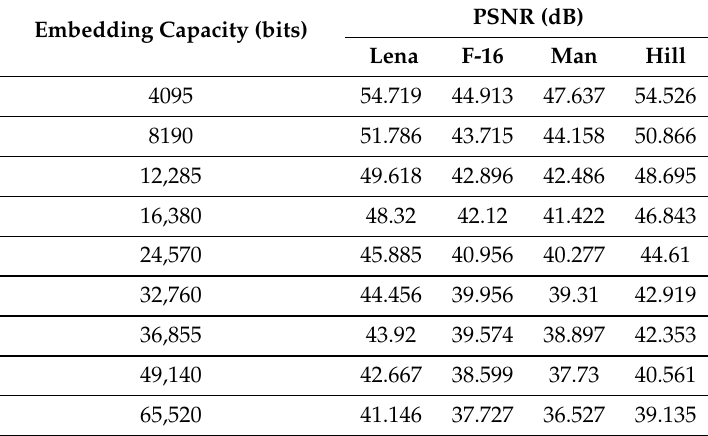
Table 2. Embedding capacity and PSNR values under n =